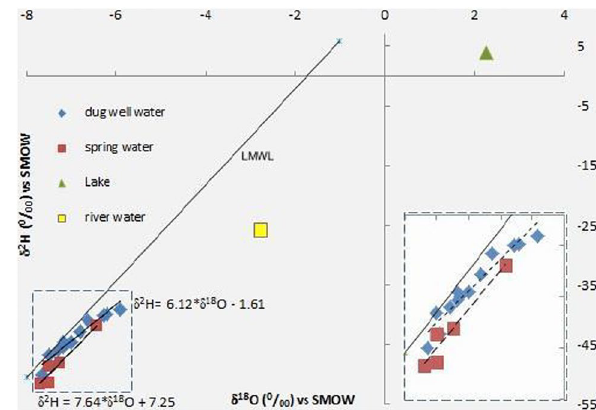
Fig. 4 Stable isotope composition of the different water types col- lected in the study